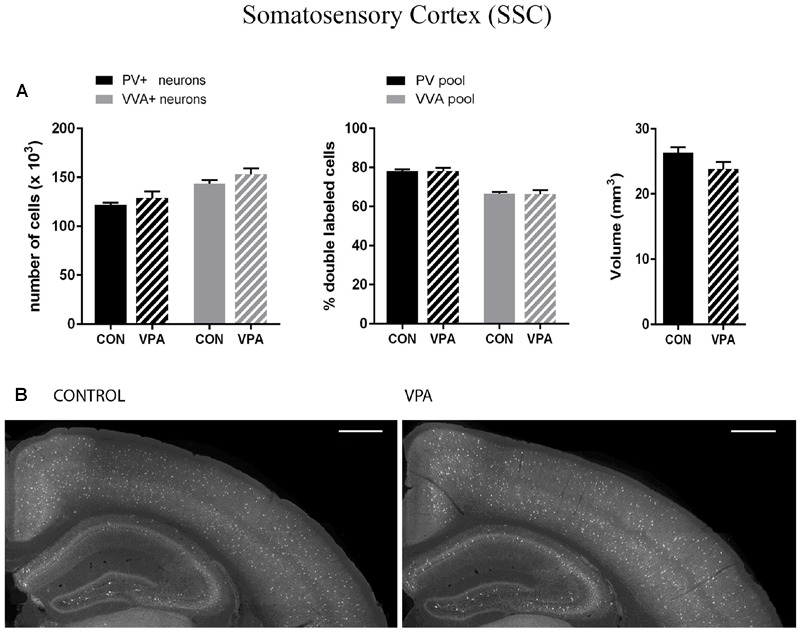
(A) Left: Stereological estimations of PV+ (black) and VVA+ (gray) cells in the SSC of PND25 in utero saline (CON) or VPA-treated male mice (N = 5 each). Middle: percentage of PV+ cells surrounded by VVA (black) and VVA+ cells showing PV expression (gray) in CON and VPA mice. Right: Volume of the ROI; i.e., the SSC. (B) Representative PV immunofluorescence images from the SSC of a CON and VPA mouse are shown. Scale bar: 200 μm. All data are expressed as mean ± SEM.